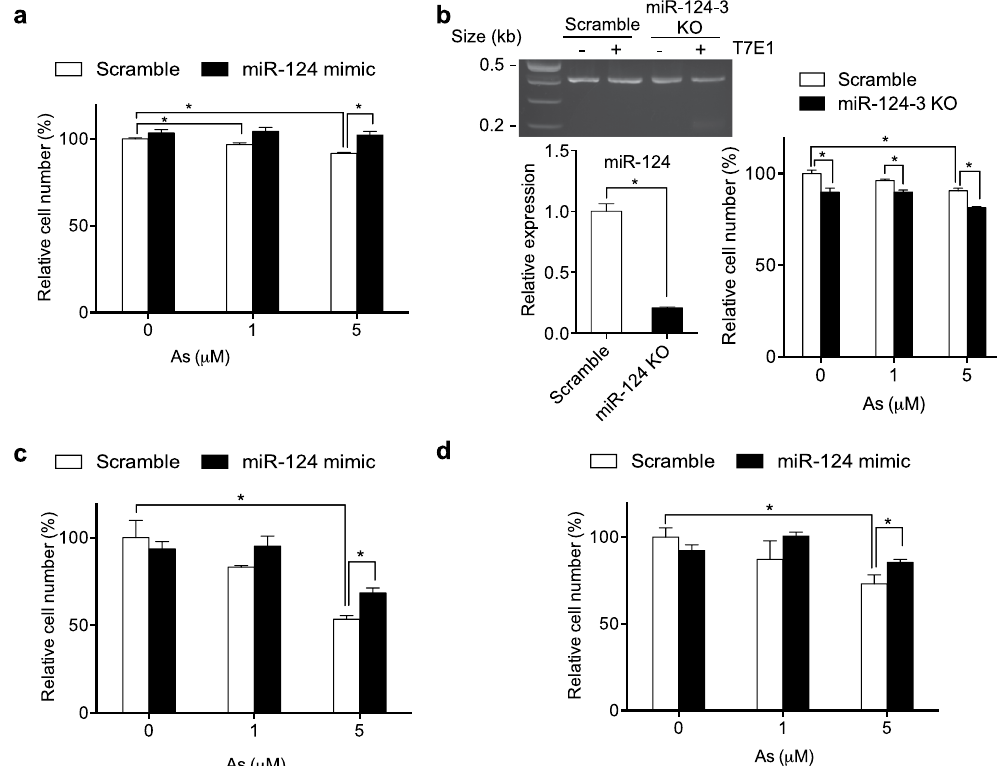
Figure 3. MiR-124 protects against As-induced cytotoxicity in human neural cells. ( a ) Effect of miR-124 overexpression on cell viability in SH-SY5Y cells. ( b ) Effect of miR-124 knockout on cell viability in SH- SY5Y cells. Left top . Validation of miR-124 knockout by T7E1 assay. Left bottom . Validation of miR-124 knockout by qRT-PCR. Right . Scrambled or miR-124 knockout SH-SY5Y cells were treated with As for 48 h. ( c ) Effect of miR-124 overexpression on cell viability in human neural stem cells (hNSCs) ( d ) Effect of miR- 124 overexpression on cell viability in ReNcell Cx neuro-progenitor cells. For mimic experiments, cells were transfected with scramble or miR-124 mimic (10 pmol/well) for 24 h, then exposed to As for 48 h. Cell viability was measured by CyQuant assay. N = 3 experiments. All error bars represent the standard error of the mean of three biologic replicates. * p <